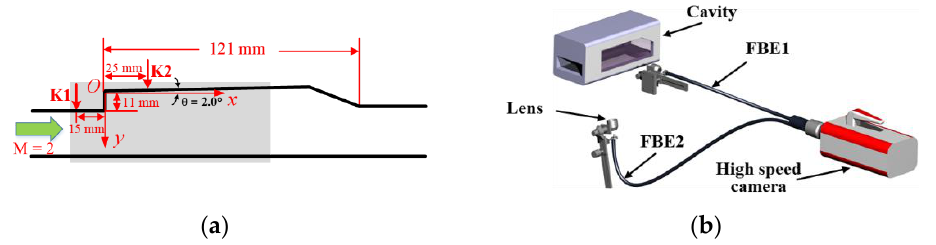
Figure 1. ( a ) Schematic of the combustor; ( b ) schematic of the measurement system. Table 1. The experimental parameters used in the present study. Table 1. The experimental parameters used in the present